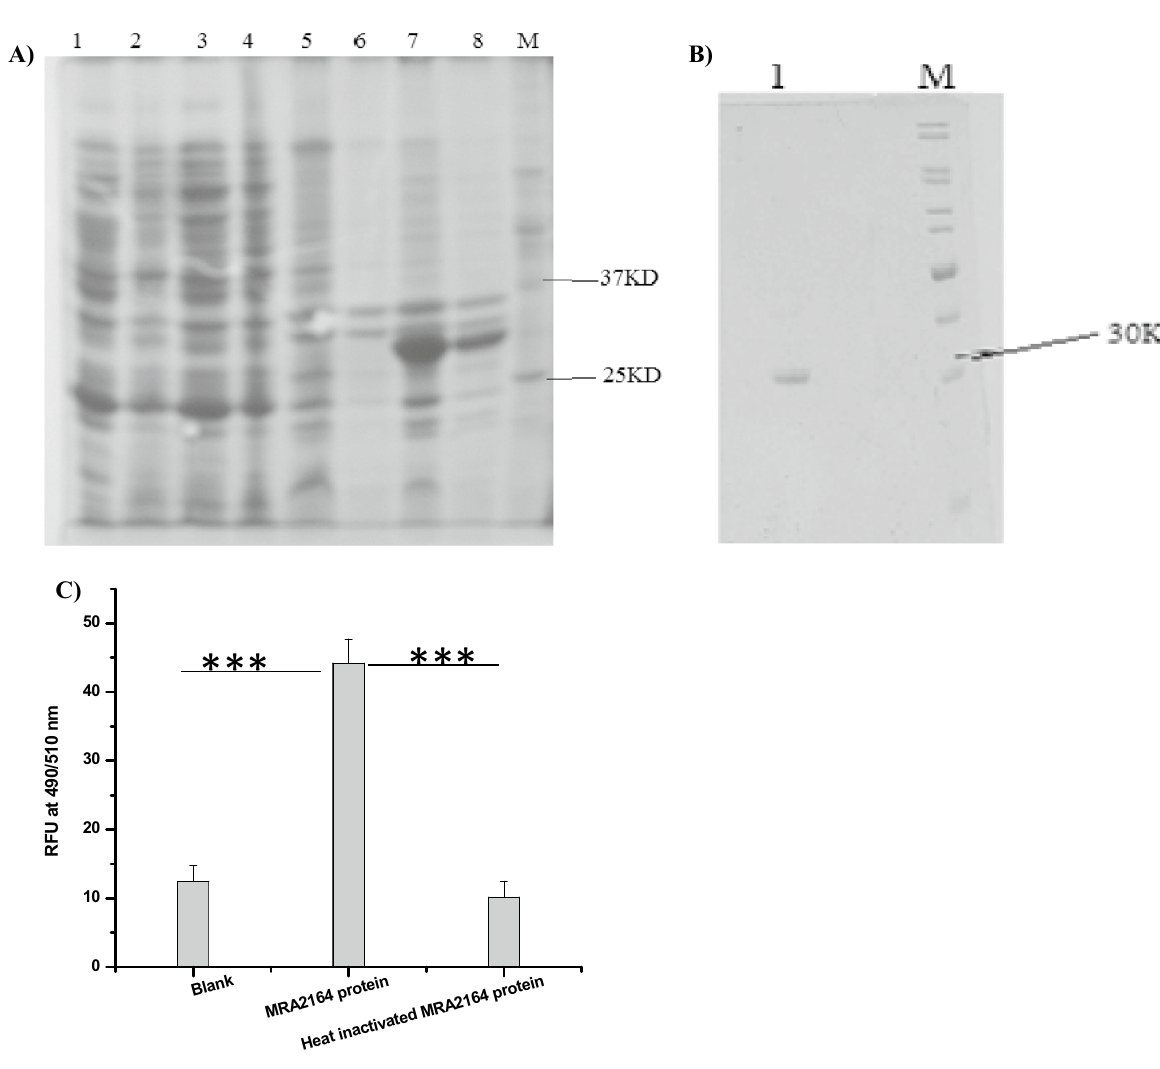
Figure 4. ( A – C ) Cloning, expression and purification of the MRA2164 gene ( A ) SDS PAGE analysis of the recombinant: MRA2164 protein Lanes 1–4 sequentially represent supernatants from E. coli Rosetta-gami, pET- 28a as vector control, induced and uninduced of MRA2164 , 5–8 are pellet from E. coli Rosetta-gami, vector control, induced and uninduced of MRA2164 gene sequentially were separated by SDS/PAGE, ( B ) SDS-PAGE of the purified recombinant enzyme with Lane 1, purified MRA2164 protein concentration of 4 µg; Lane M, Molecular weight markers are indicated at Right. ( C ) NO synthesizing activity of the pure protein in presence of nitrite as a substrate. More details are provided in the “Materials and Methods” section. The data represented as the mean of three experiments ± SD (*** P < 0.01).